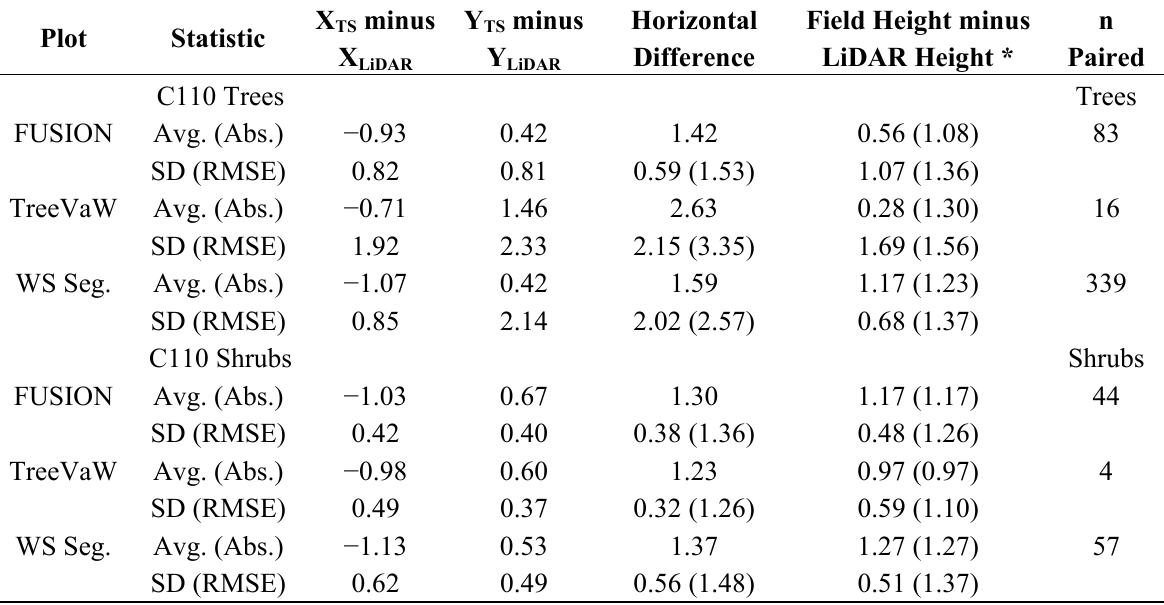
Table 10. LiDAR tree extraction method comparing spatial location and height (m) of trees and shrubs to field measurement in one clearcut plot.